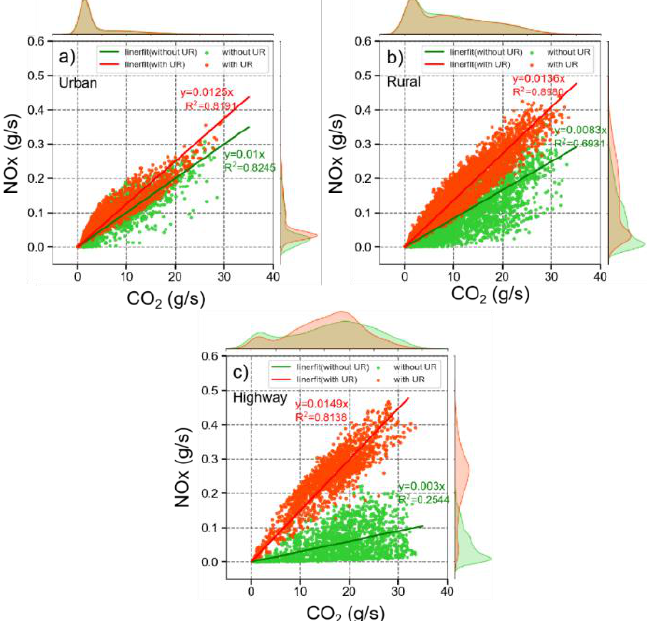
Figure 6. Scatter correlation diagrams of NOx instantaneous mass emission rates as a function of CO 2 for the vehicle with and without the UR under urban ( a ), rural ( b ), and highway ( c ) driving conditions.